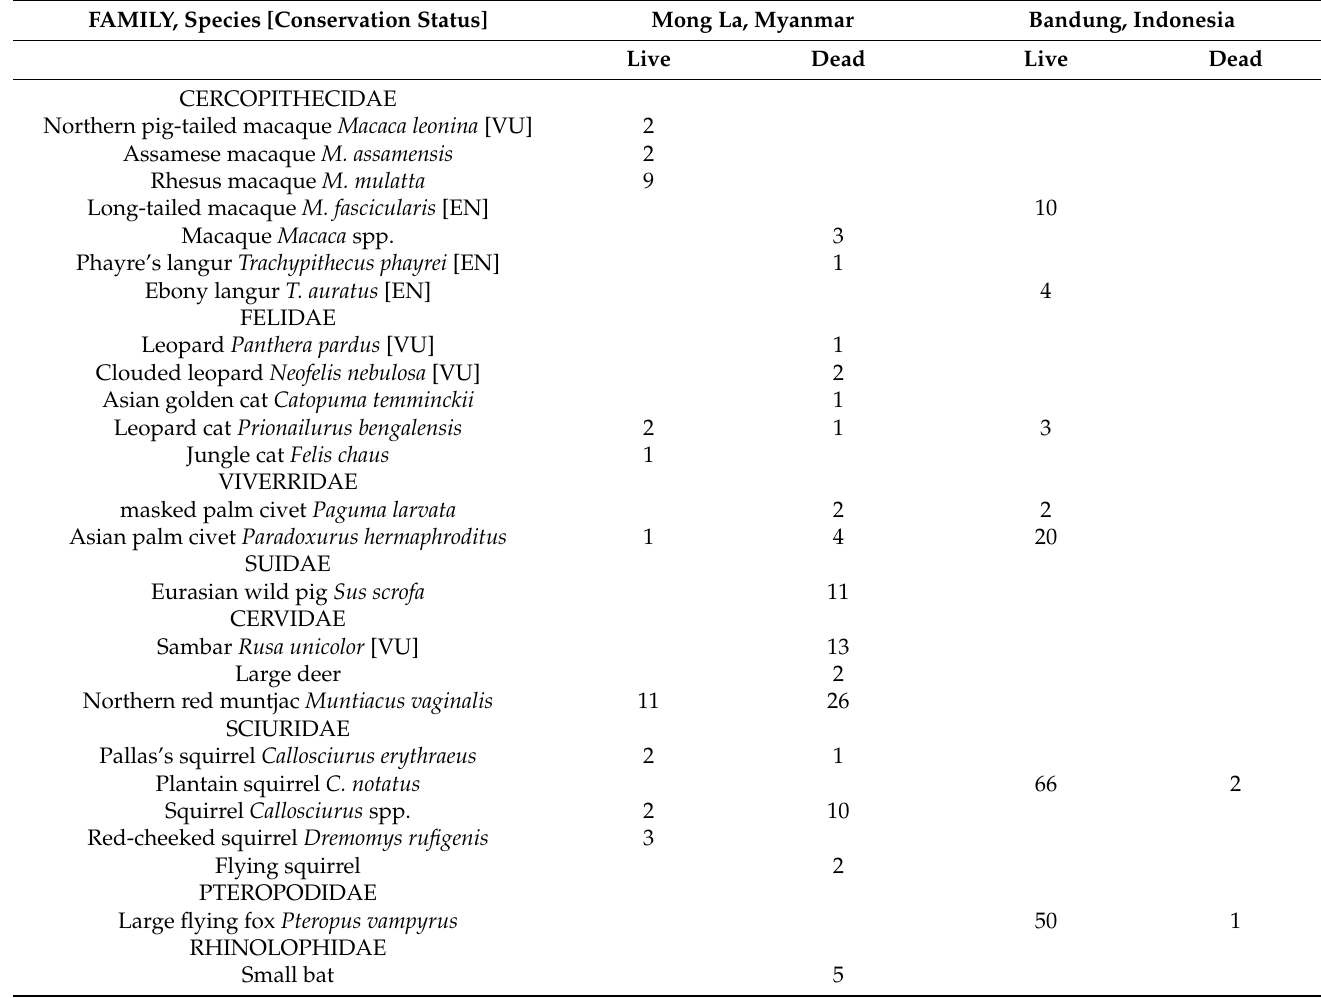
Table 2. Individuals of eight mammal families (Cercopithecidae, Felidae, Viverridae, Suidae, Cervidae, Sciuridae, Pteropodidae, Rhinolophidae) * recorded in two live and wet markets in Myanmar and Indonesia. Key to global conservation status: CR = Critically Endangered; EN = Endangered; VU =